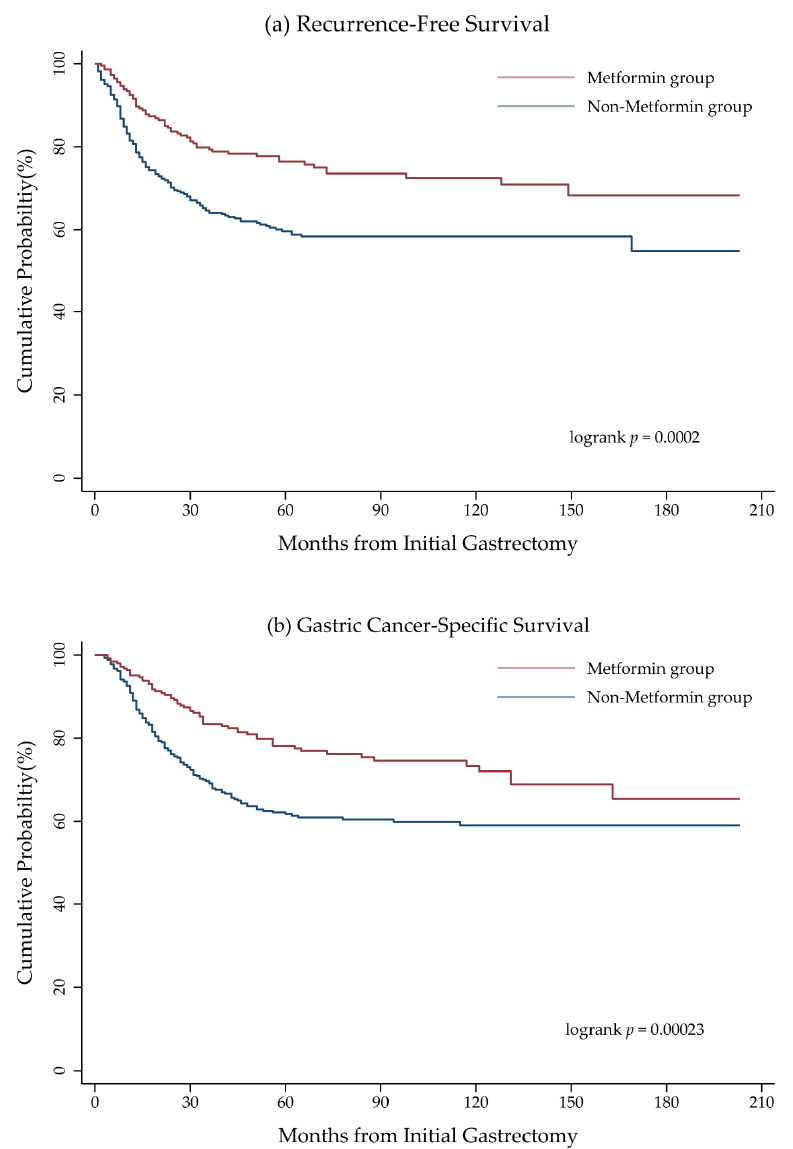
Figure 2. ( a ) Recurrence-free survival and ( b ) cancer-specific survival in patients with stage I–III GC and DM in terms of metformin use.